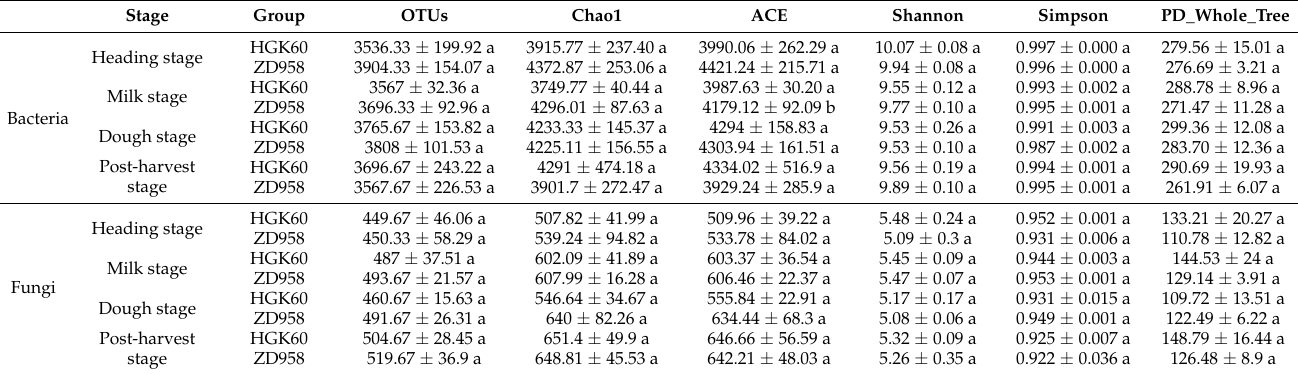
Table 1. Diversity index of rhizosphere bacteria and fungi in different